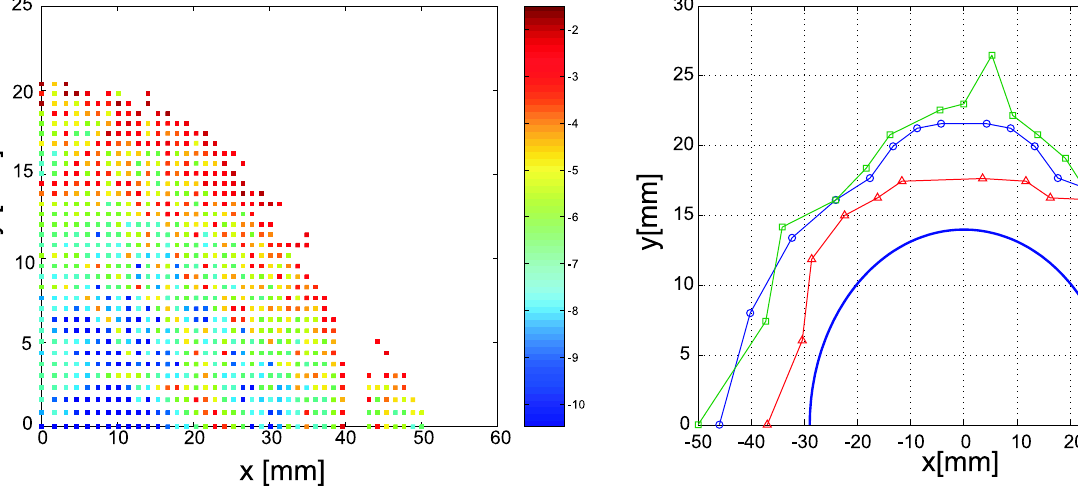
FIG. 11. (Color) Dynamic aperture with FMA, for the mode with momentum compaction 2 (cid:1) 10 (cid:2) 4 .